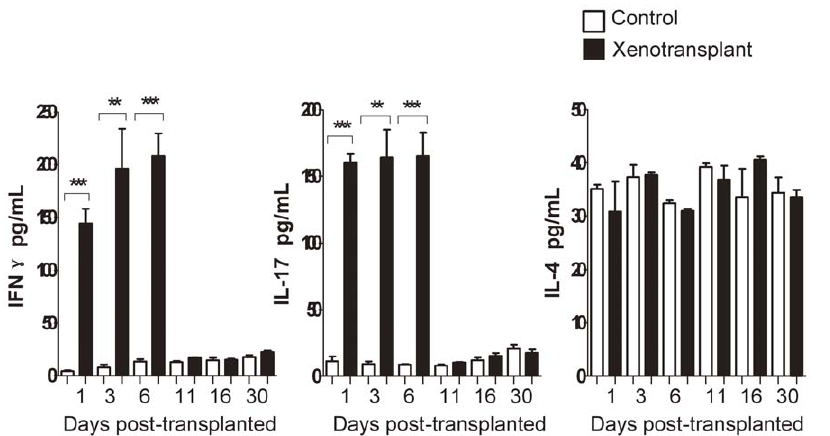
Figure 3. ELISA assays of IFN- c , IL-17 and IL-4 in serum. Sera from collected blood at each time point (1, 3, 6, 11, 16, and 30 days) from xenotransplanted and sham control mice were used for ELISA analysis. Sera IFN- c and IL-17 levels in the xenograft group were significantly higher than those in the serum in the control group (p , 0.05) at day 1, day 3 and day 6, and decreased to control levels by day 11. There is no significant difference of IL-4 levels between recipients and control group. *, p , 0.05; **, p , 0.01; *** p , 0.001. (We performed this experiment